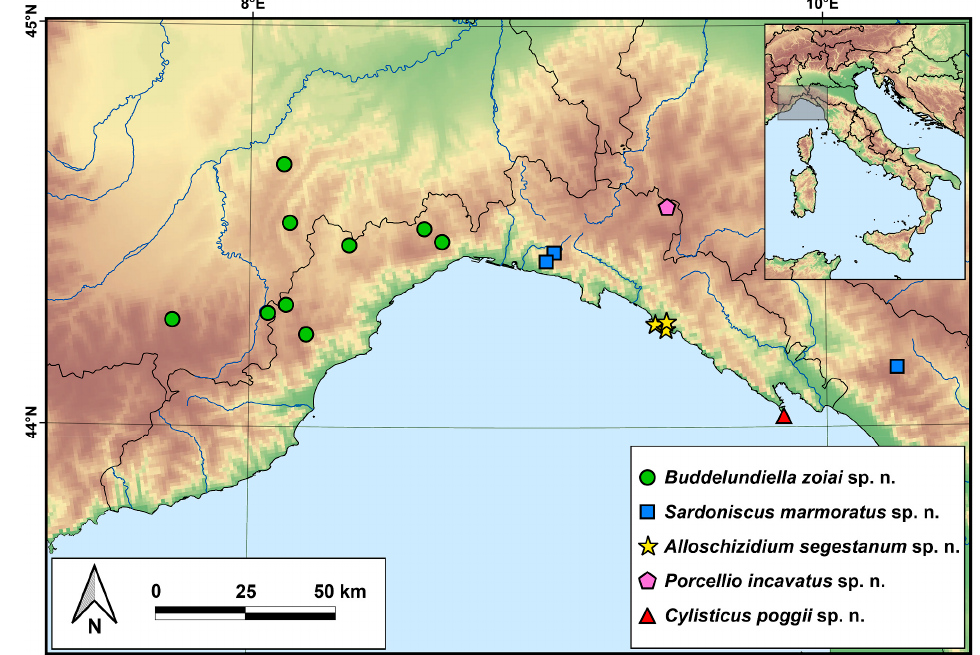
Figure 16. Distribution map of the five new species of Oniscidea from Liguria and surrounding regions.